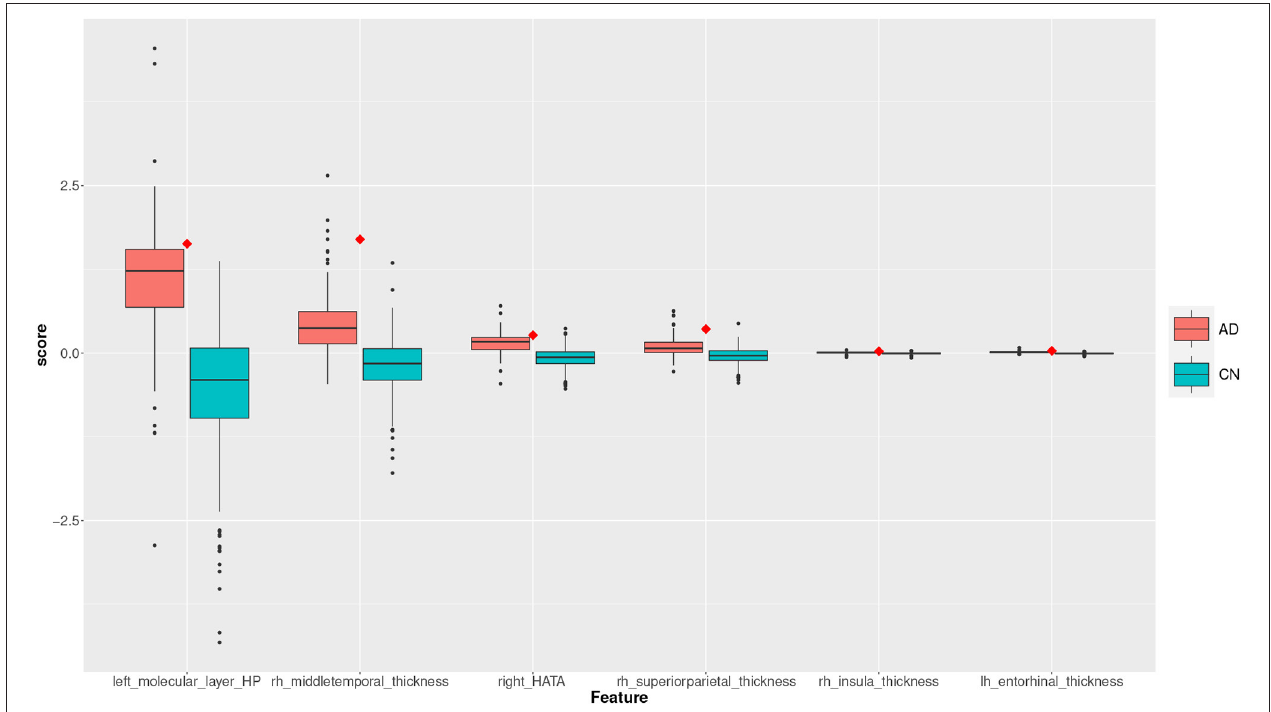
FIGURE 8 | Feature scores of a True Positive (TP) example. The quartiles are generated from the hold-out training data; the example case is selected from the hold-out test data.